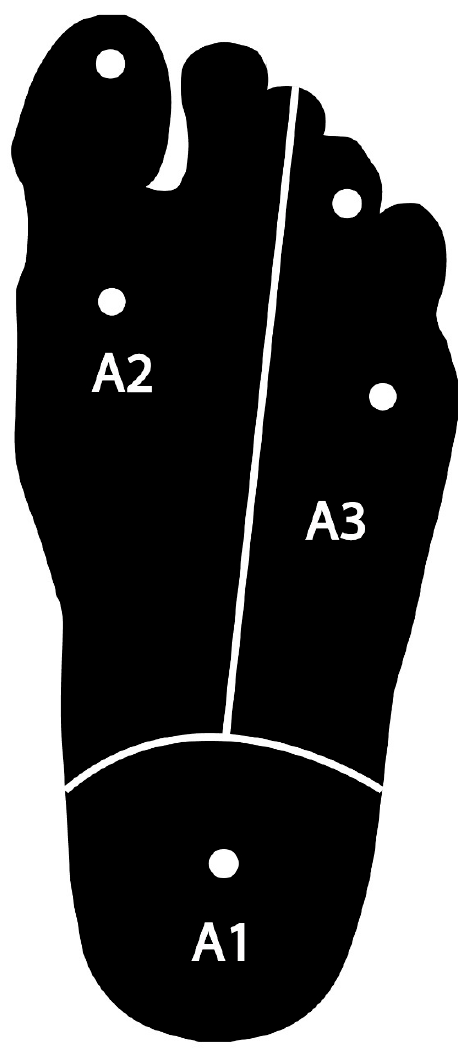
Figure 3. Division of the tibial nerve dermatome into three areas. A1 is the area innervated by the calcaneal nerve. A2 is the area innervated by the medial plantar nerve. A3 is the area innervated by the lateral plantar nerve. The circles mark the anatomical zones in which the two types of sensitivity (thermal and pain) were tested.